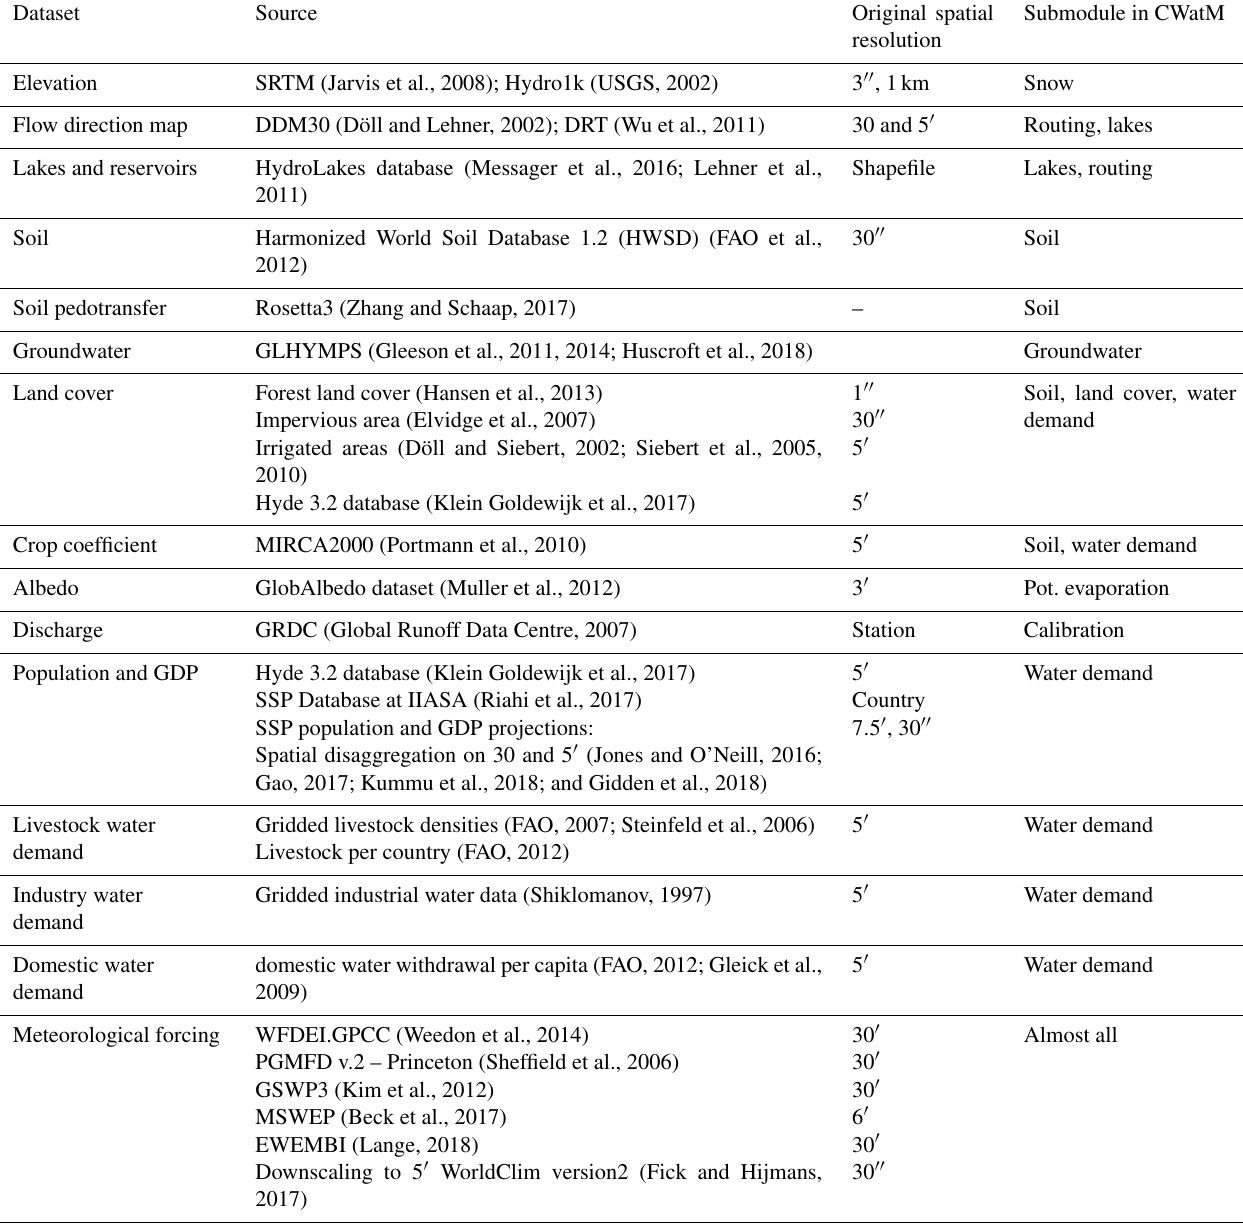
Table 1. Global dataset, source of dataset and submodule of CWatM.